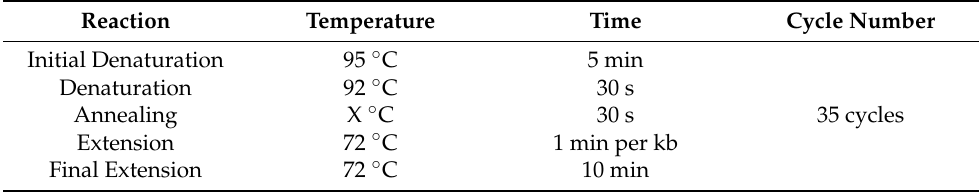
Table 6. Cycling condition for colony